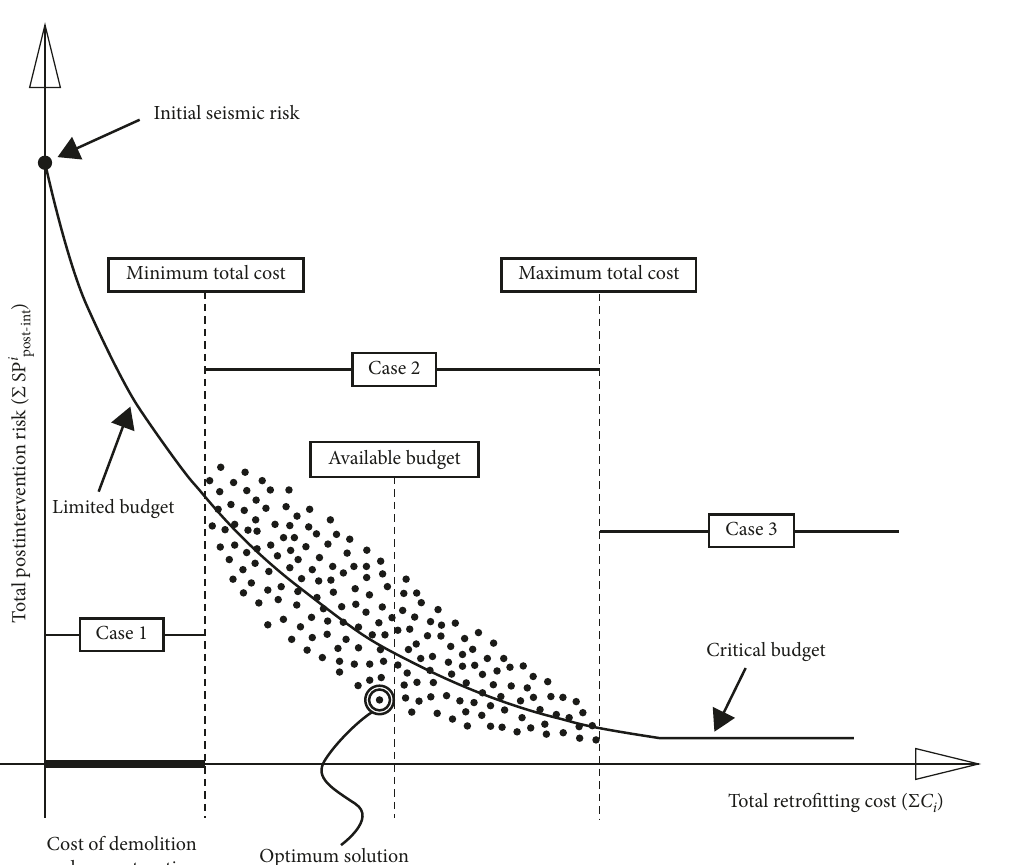
Figure 4: Total cost of retrofitting versus total postintervention risk